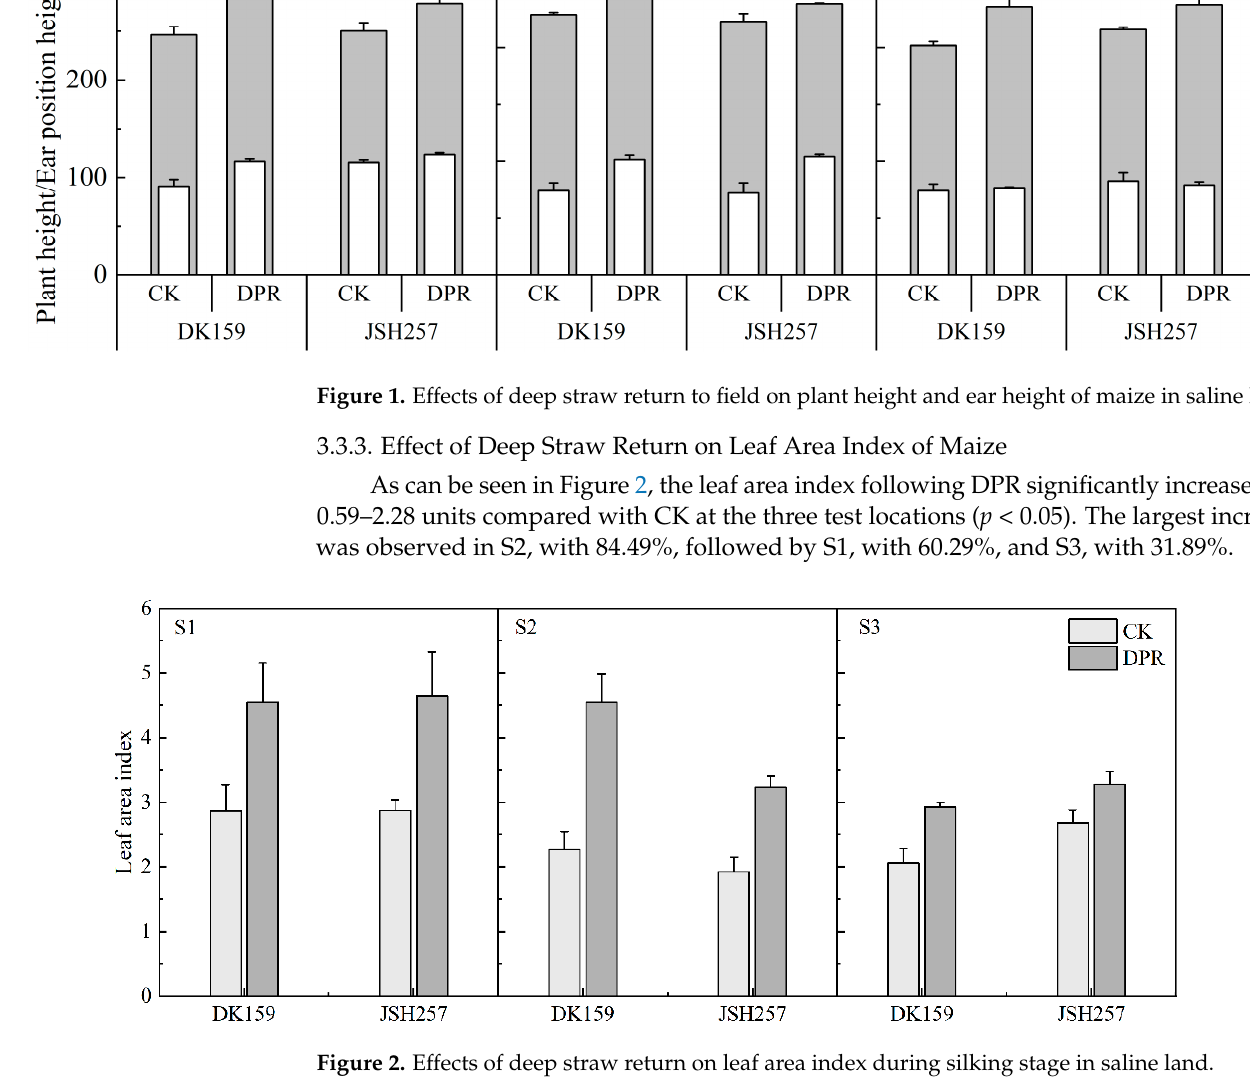
Table 7. Analysis of variance of corn yield and its constituent factors following each treatment (F-